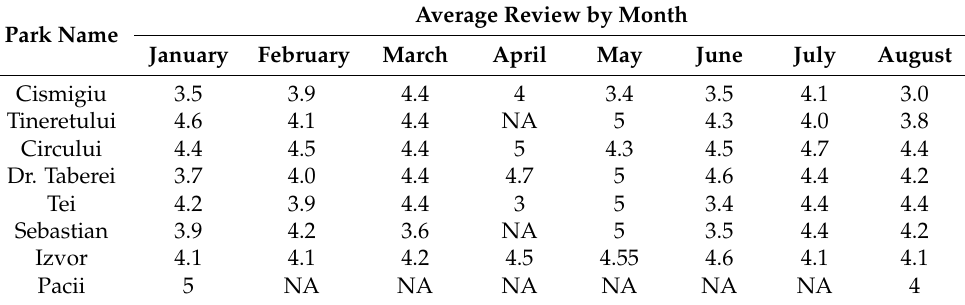
Table 4. The average review by month for selected